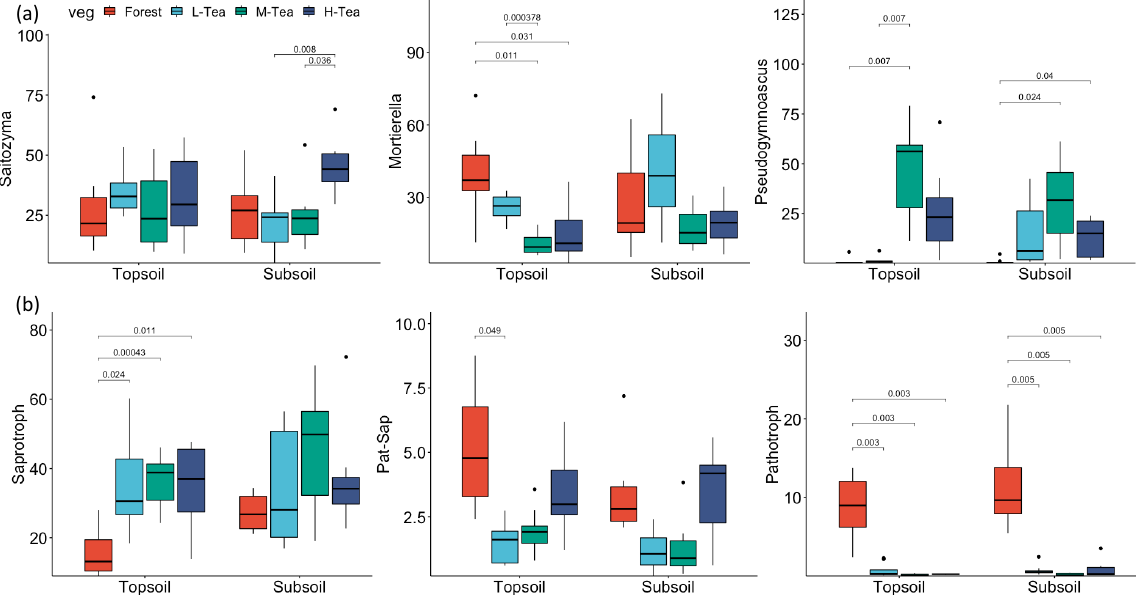
Figure 2. Dominate fungal genus ( a ) and functional guilds ( b ) in topsoil and subsoil in forests compare to tea plantations under high (H), low (L), and moderate (M) fertilizer inputs.